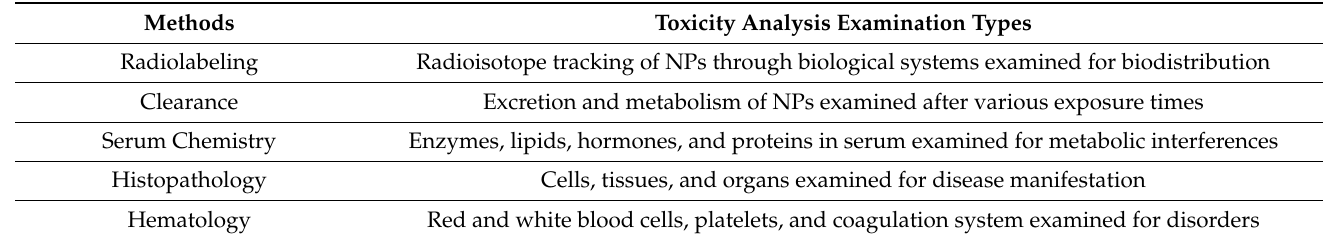
Table 2. In vivo methods for nanotoxicity